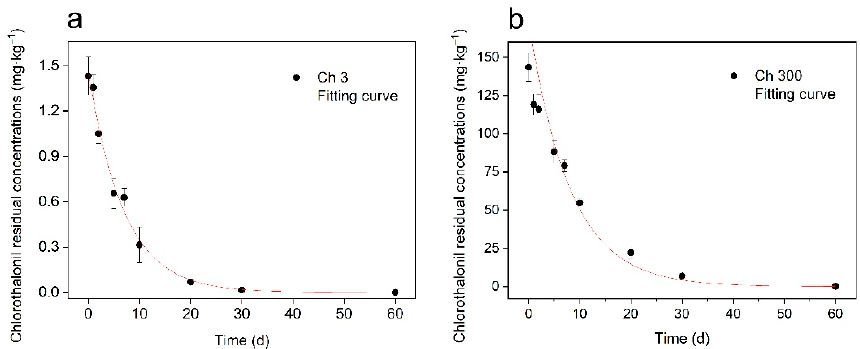
Figure 1. Dissipation of chlorothalonil in yellow–brown loam soil. ( a ) dissipation of chlorothalonil in soil after single applications of 3.0 mg·kg − 1 of dry soil; ( b ) dissipation of chlorothalonil in soil after single applications of 300 mg·kg − 1 of dry soil. All values represent mean ± standard deviation of triplicate samples. Ch 3 represents soil with 3.0 mg·kg − 1 chlorothalonil. Ch 300 represents soil with 300 mg·kg − 1 chlorothalonil. The same below.